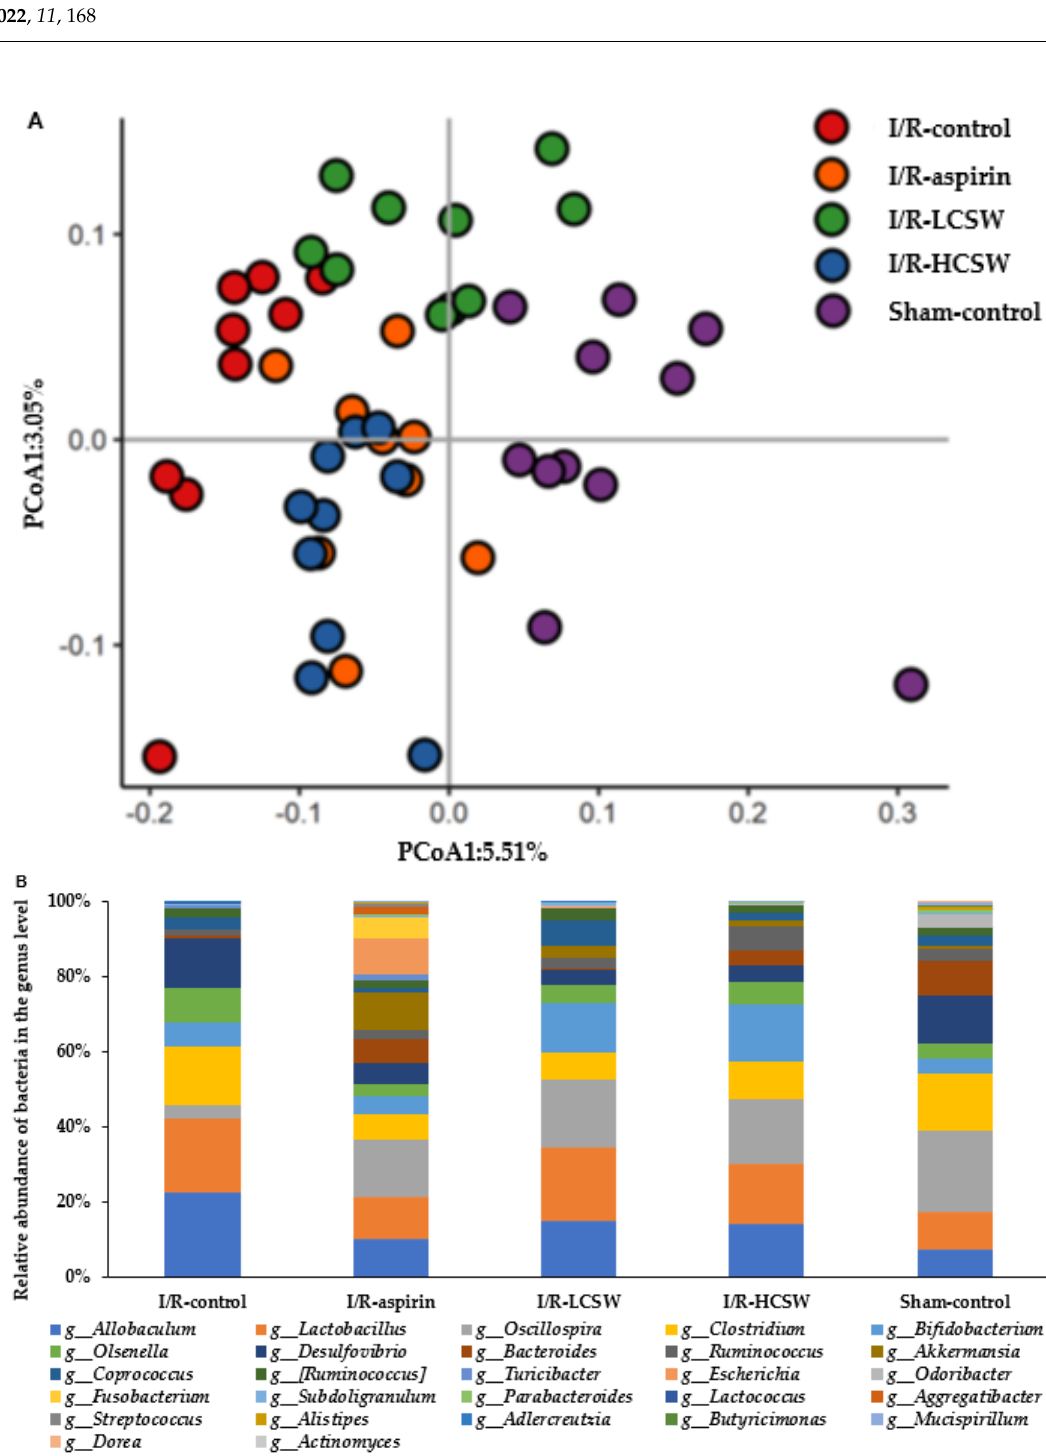
15 of 21 Table 5. Serum short-chain fatty acid (SCFA) concentrations, α-diversity, and metagenome analysis. I/R-Control ( n = 10) 2.76 ± 0.11 a Gerbils that underwent the transient ischemic attack by carotid artery occlusion for 8 min and reper- fusion were randomly divided into four groups, as follows: (1) 0.2% cellulose (I/R-control), (2) 0.02% aspirin (I/R-aspirin), (3) 0.05% freeze-dried corn silk water extract (I/R-LCSW), and (4) 0.2% CSW